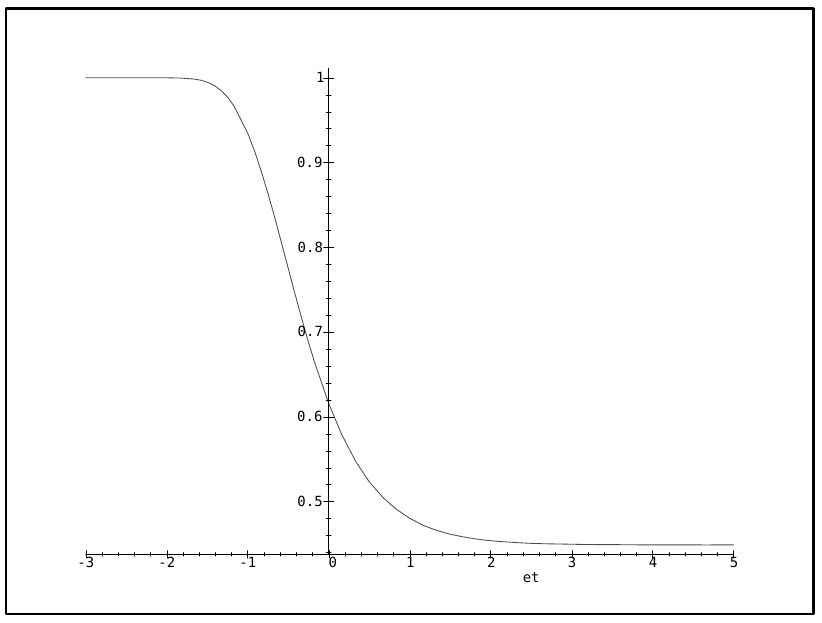
2, observed = circle, asymptotic = line) (cid:0)